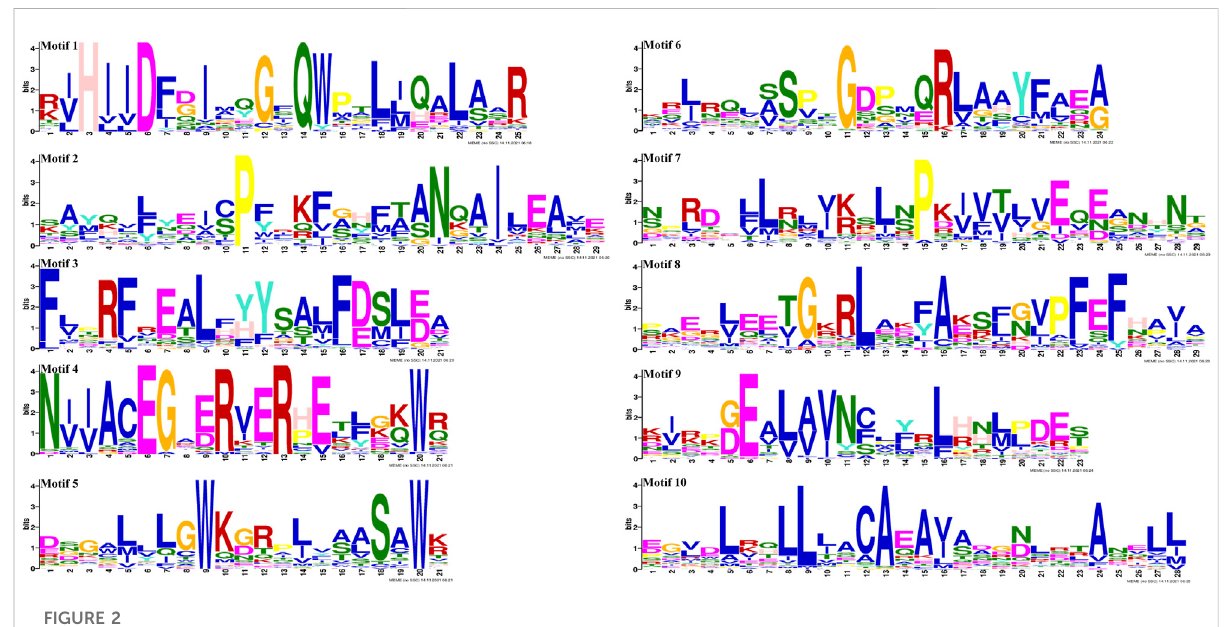
FIGURE 2 SmGRAS protein motifs con fi rmed using CDD of